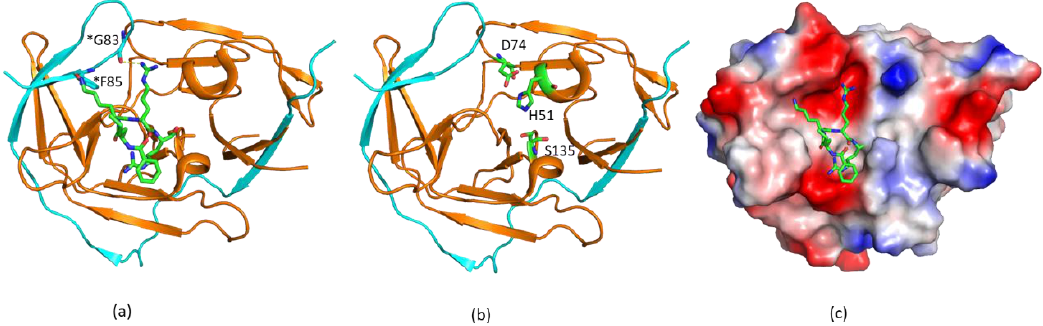
Figure 1. Structures of West Nile virus (WNV) protease in complex with an inhibitor. ( a ) The crystal structure of WNV NS2B-NS3pro in complex with an inhibitor. The non-structural protein 2B (NS2B) cofactor region and NS3pro are shown in cyan and orange, respectively. The inhibitor is shown in sticks, and residues from NS2B having close contacts with the inhibitor are labeled. Residues from NS2B are labeled with an asterisk. ( b ) The catalytic triad of WNV protease. The residues forming the catalytic triad are labeled and shown in sticks. ( c ) Surface representation of WNV protease. Surface charge analysis of the structure is shown. The structure was obtained from the Protein Data Bank (PDB) with access code 2FP7.